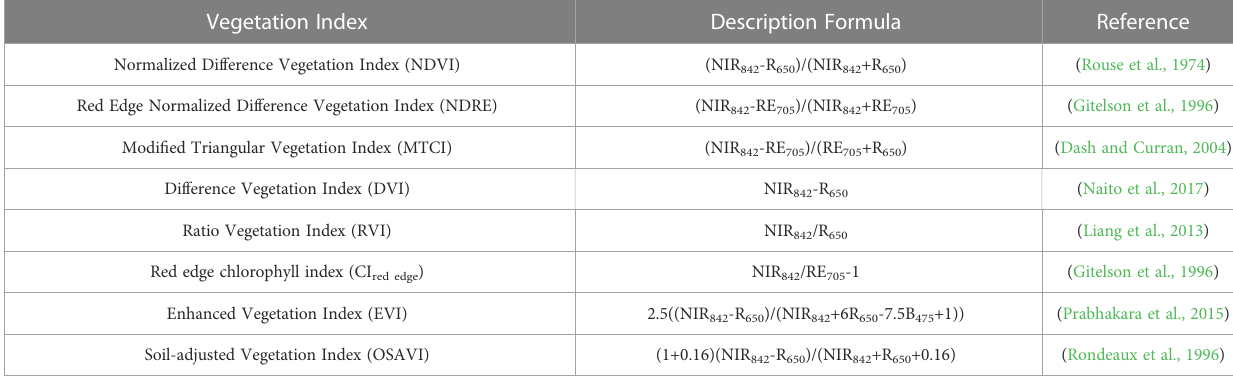
TABLE 2 Formula for calculating vegetation